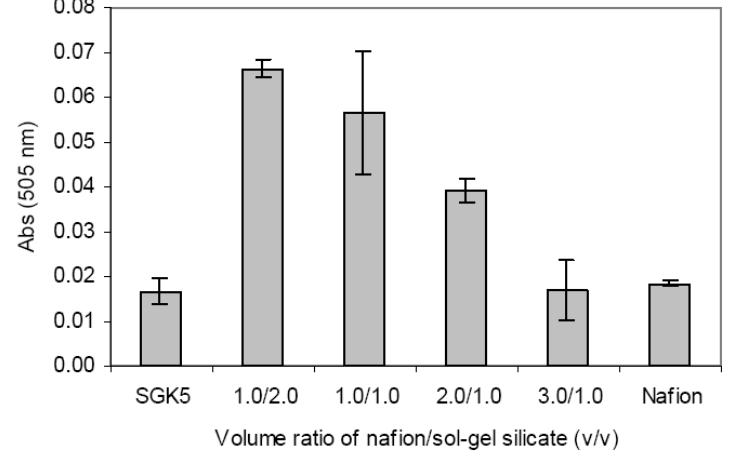
Figure 4 . Effect of volume ratio of nafion/sol-gel silicate on the biosensor response. Catechol concentration was fixed at 6.5 mM in phosphate buffer (pH